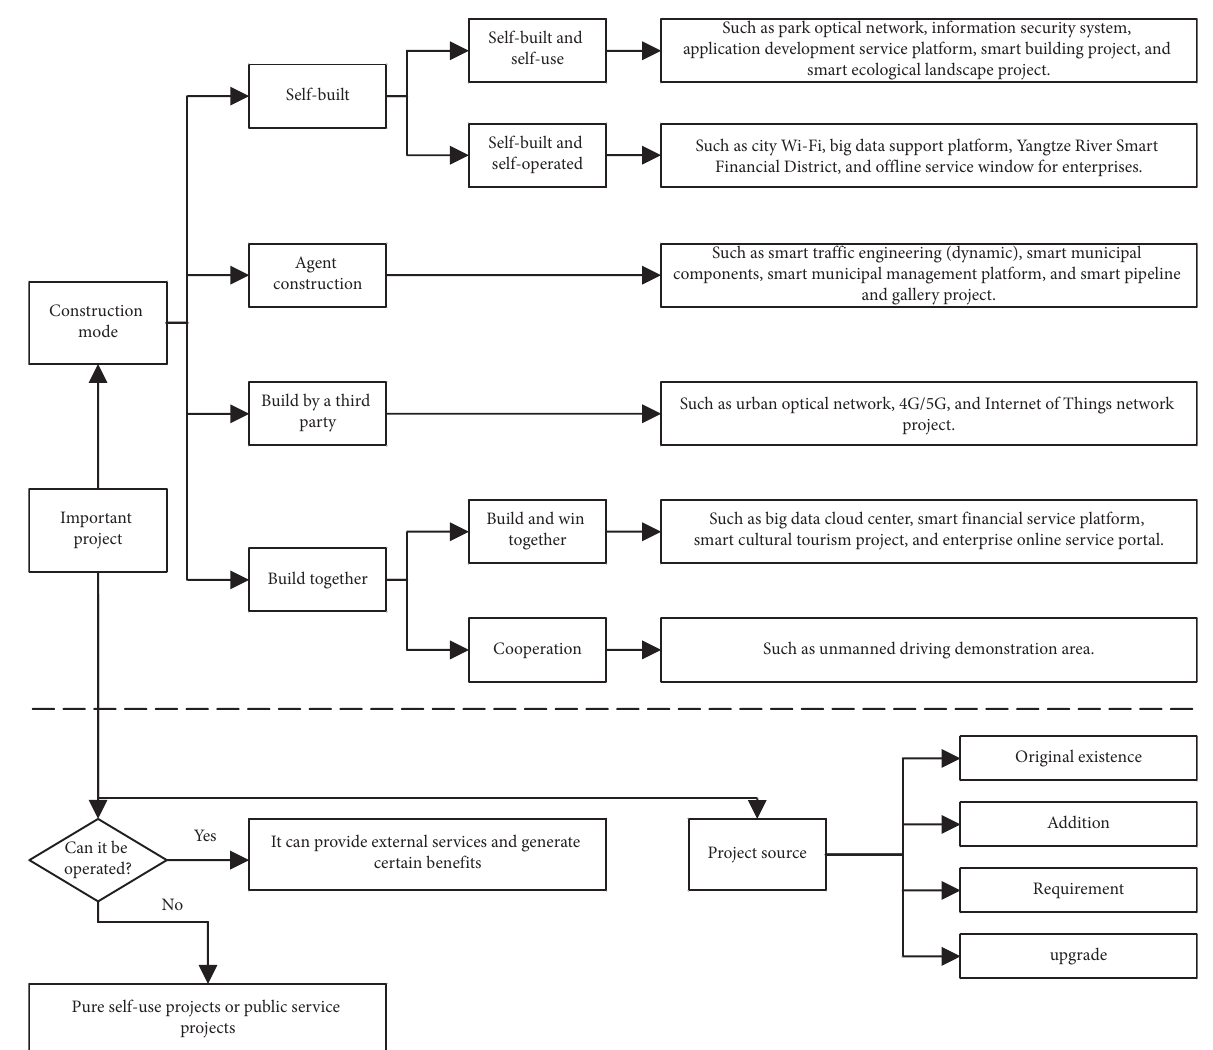
Figure 6: Business model design of the CBD in the Jiangbei New